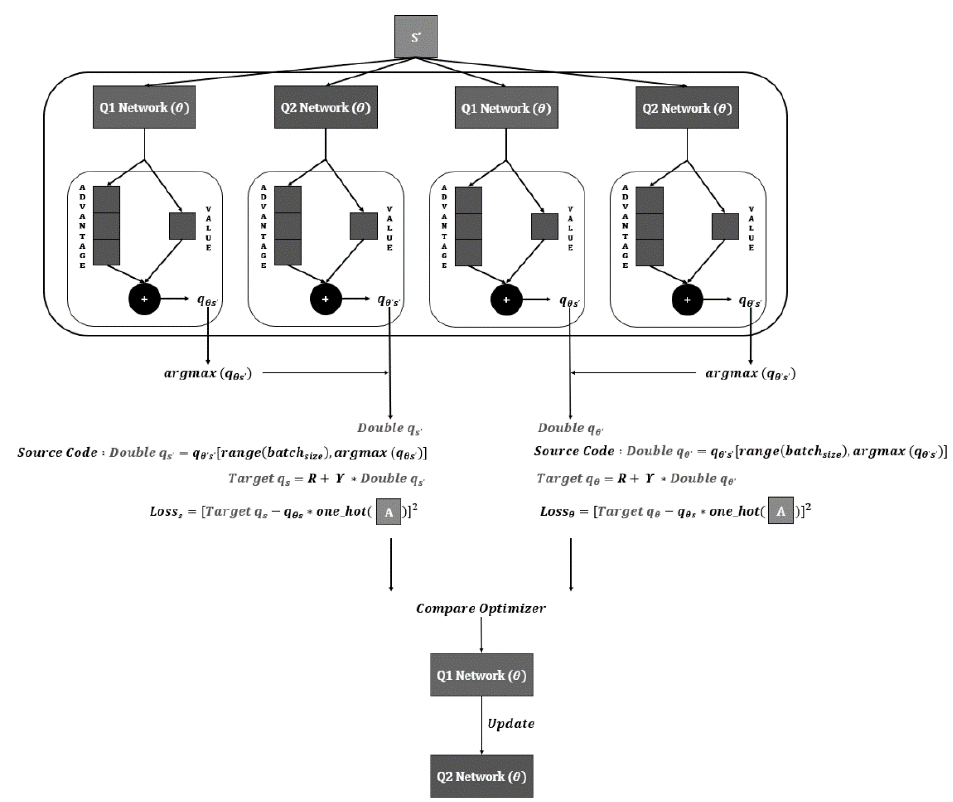
Figure 4. Quad Q Network algorithm structure that derives Target Q values with the structures of the Quad Q Network with four Q Networks.